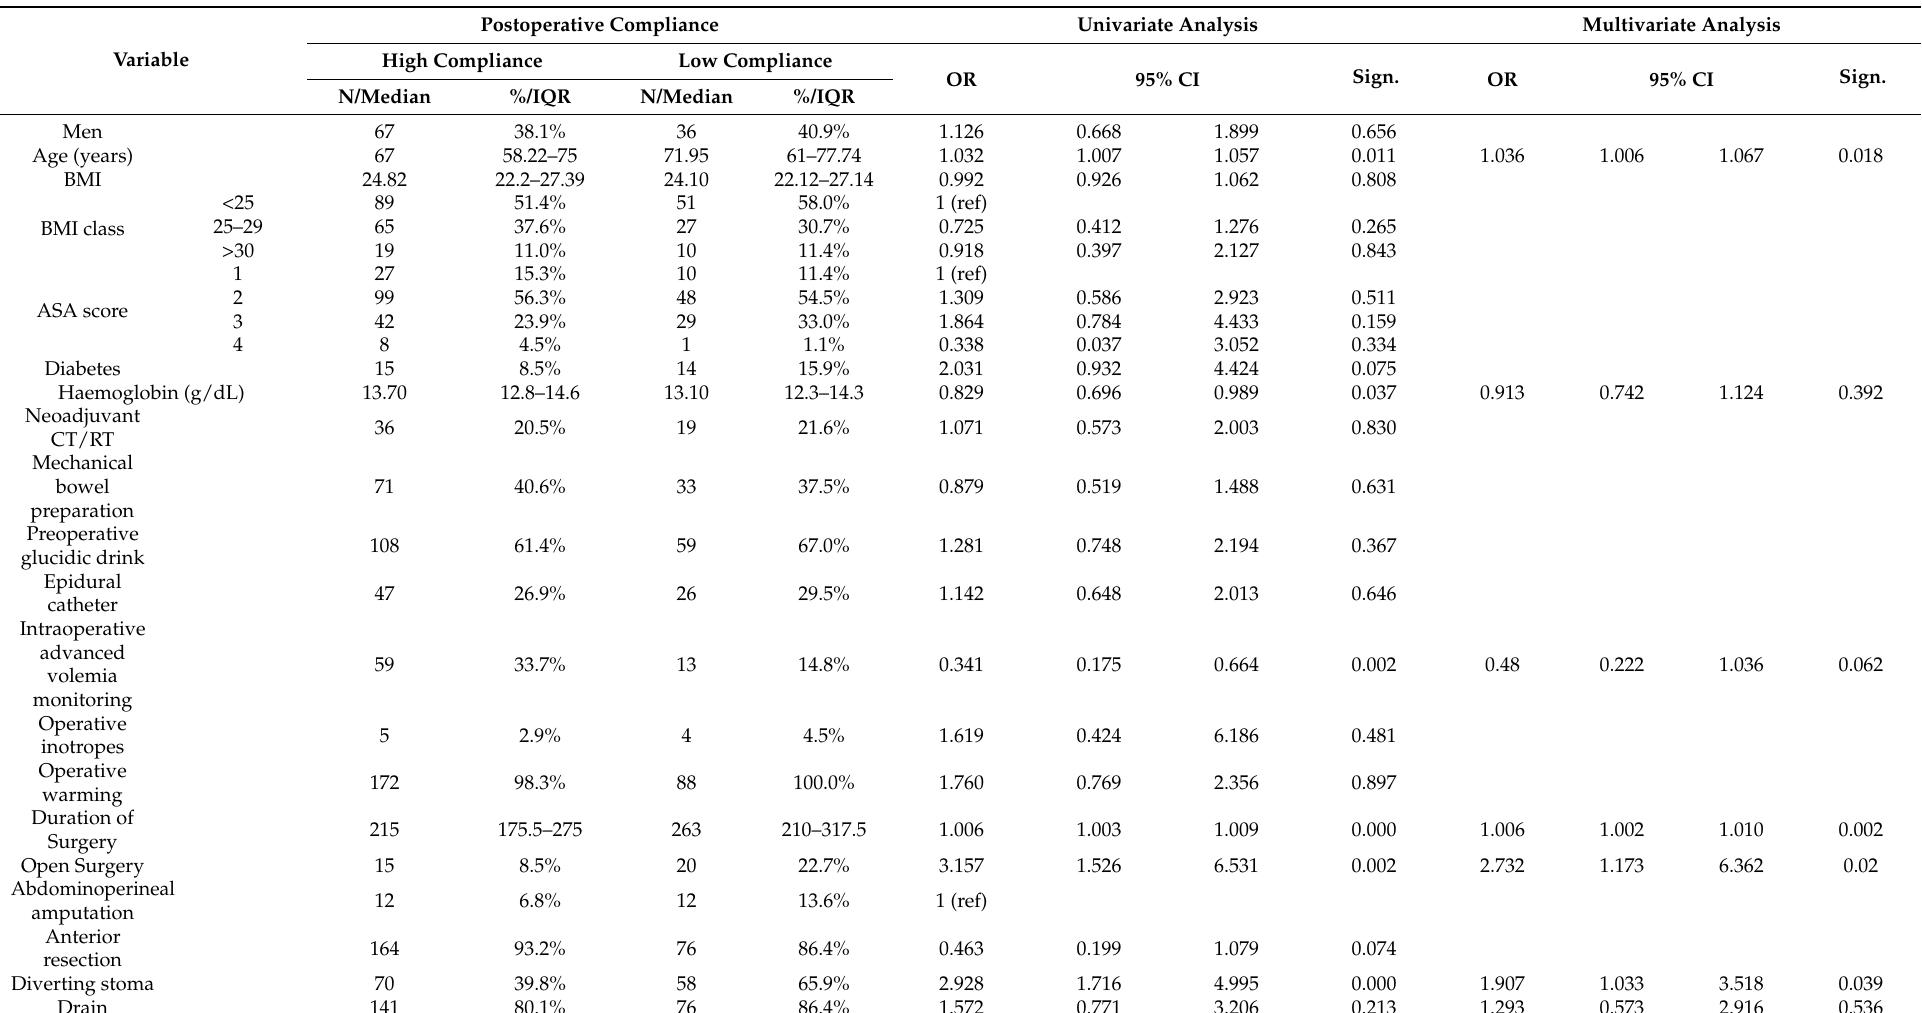
Table 3. Variables associated with low compliance on postoperative day